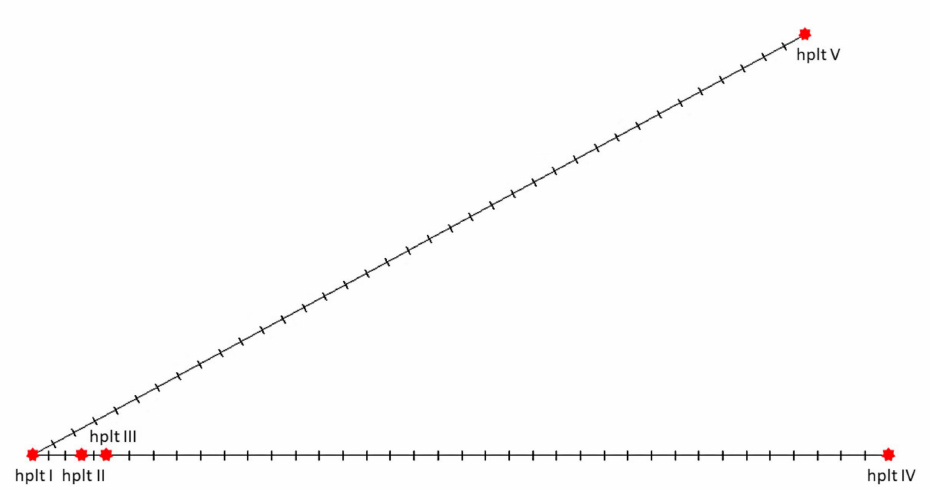
Figure 10. The median-joining network of five mitochondrial haplotypes identified in the studied individuals (hplt—haplotype; vertical bars indicate distinguishing variable positions; haplotype designation with Roman numerals explained in the